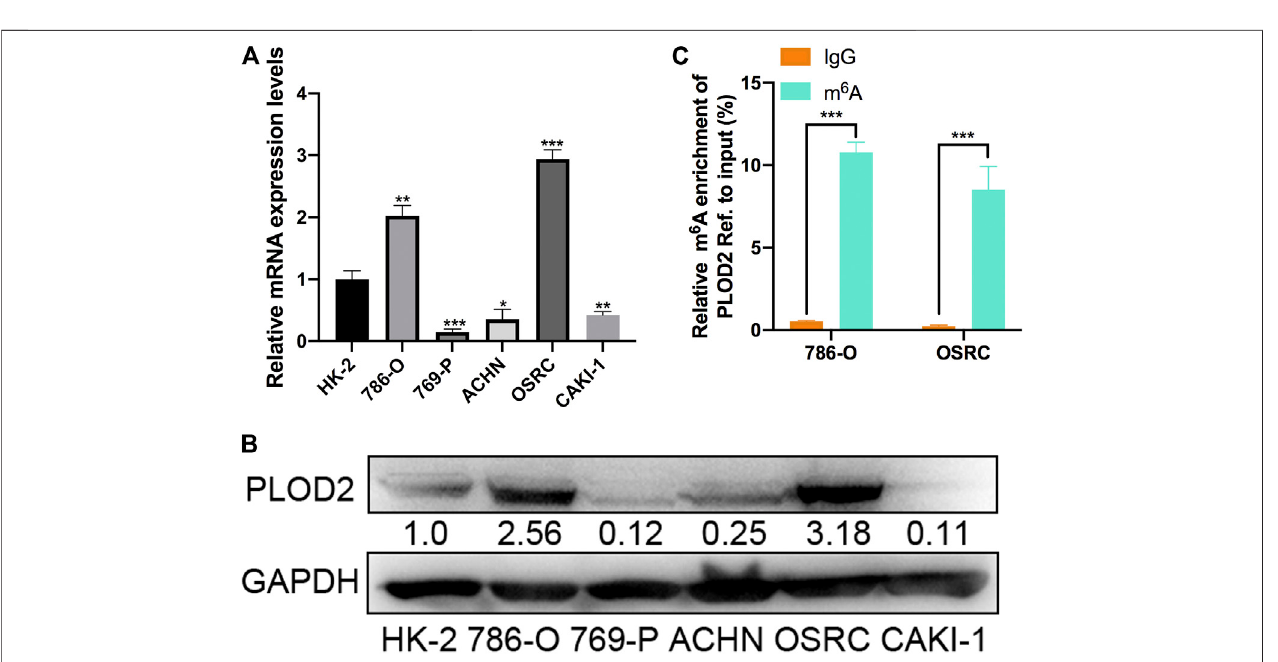
FIGURE2| The mRNAand m 6 Amethylationlevels ofPLOD2 were obviously increased inRCC cell lines. (A,B) PLOD2 mRNA and protein expressions inRCCcell lines(786-O,769-P,ACHN,OSRC,andCAKI-1)andnormalepitheliumcellsofrenaltubuleHK2byRT-qPCRandwesternblot. (C) m 6 AenrichmentofPLOD2in786-O and OSRC RCC cells detected by MeRIP-qPCR. * p < 0.05, ** p < 0.01, *** p < 0.005.